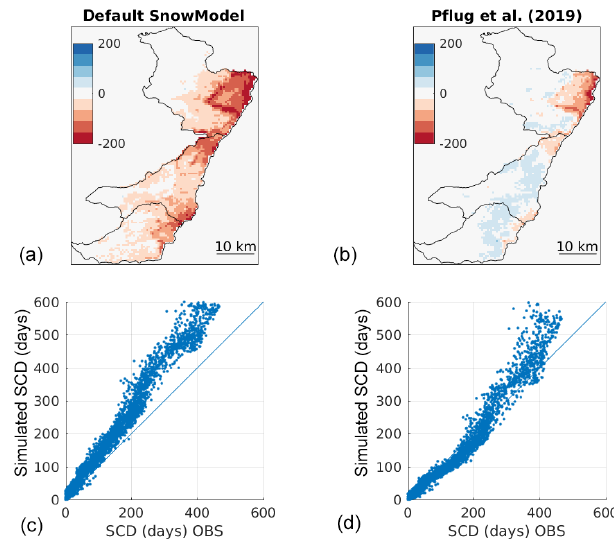
Figure 6. (a, b) Difference in days between the MODIS and simu- lated snow cover duration (SCD), computed over the entire period of the simulation (three snow seasons, from 1 November to 30 June, between 2013 and 2016) using the default SnowModel and the Pflug et al. (2019) model configurations. (c, d) The scatterplots show the pixel-by-pixel comparison of the simulated and MODIS SCD.